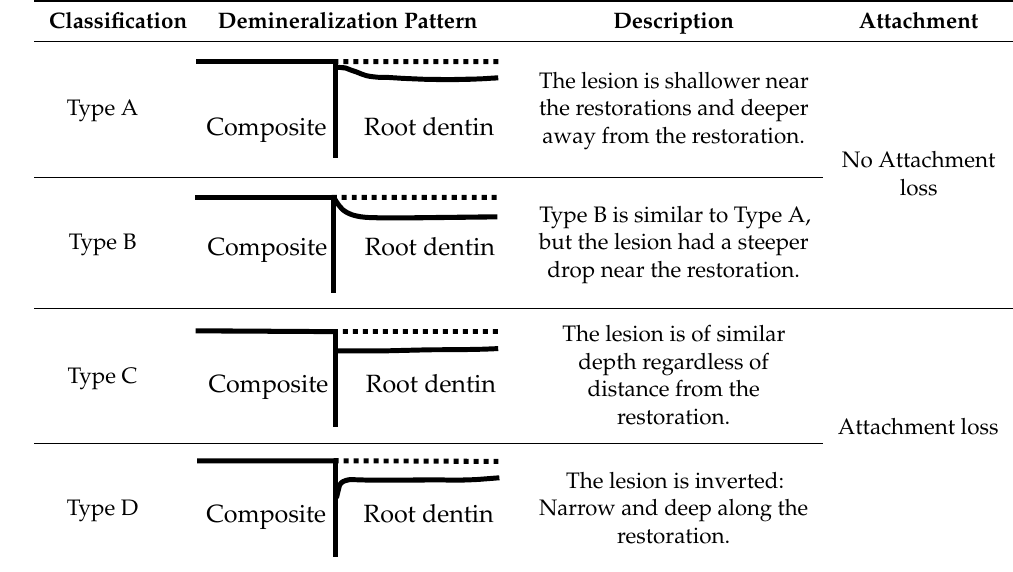
Table 2. Artificial caries pattern: demineralization pattern of the lesions near the composite resto- ration over root dentin region by using SS-OCT.